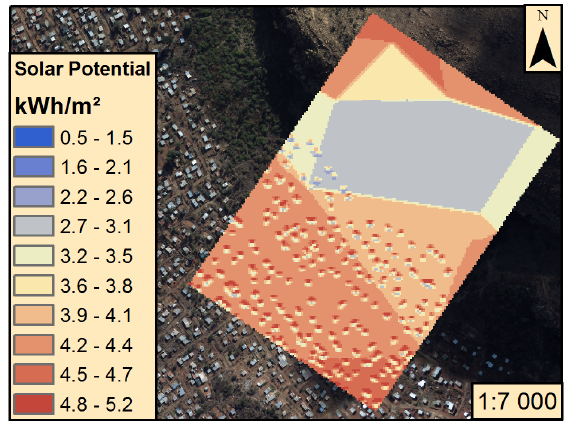
Figure 7. Solar radiation model for Alaska derived from the 2m DSM